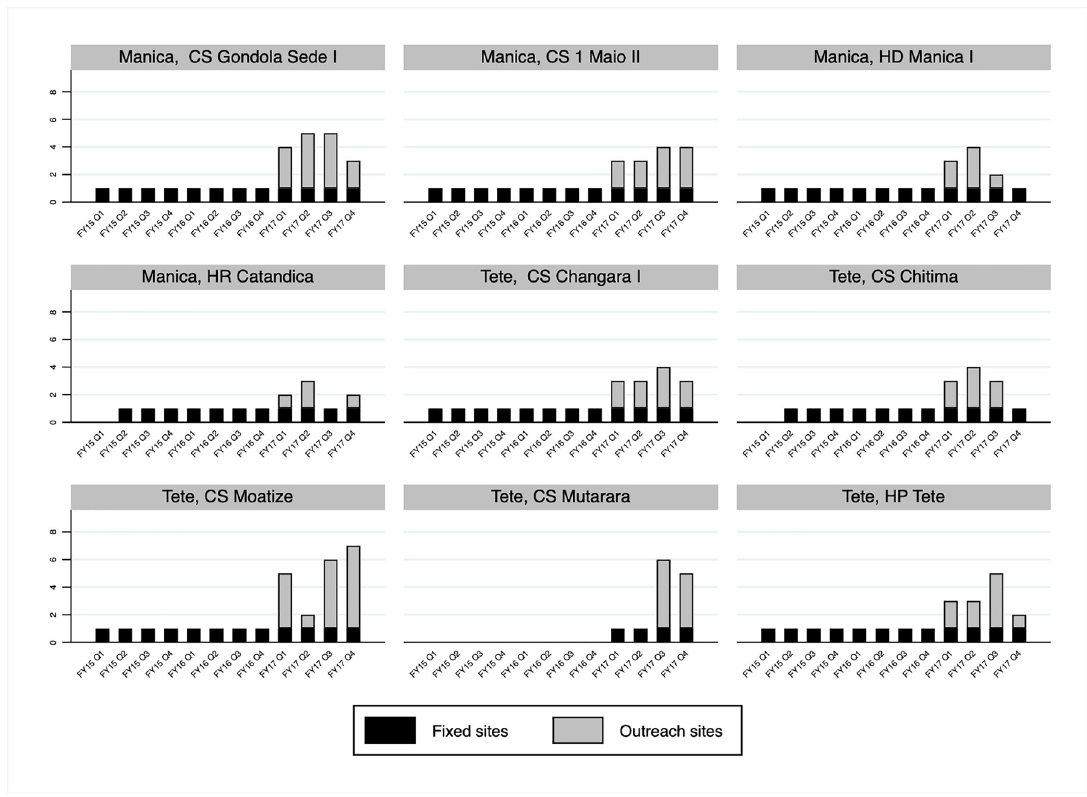
Fig 3. Numbers of fixed and outreach service delivery sites performing voluntary medical male circumcisions (VMMCs) in Manica and Tete, Mozambique FY15 Q1- FY17 Q4 by fixed service delivery site.